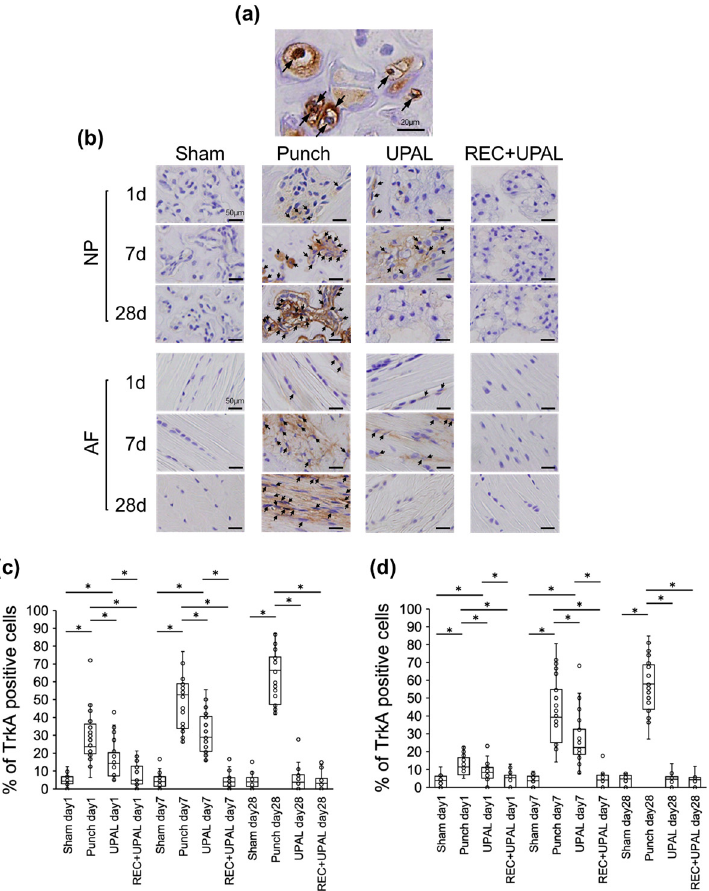
Figure 4. A mixed solution of REC and UPAL inhibits tyrosine kinase A (TrkA) receptor upregulation. Immunohistochemical analysis was performed on postoperative days 1, 7, and 28 to detect TrkA levels ( a – d ). ( a ) Representative image of TrkA-positive nucleus pulposus (NP) (allows). TrkA-positive cells are stained in brown, and nuclei are stained in purple. Scale bar, 20 μ m. ( b ) Representative IHC staining for TrkA of NP and annulus fibrosus (AF) tissues on postoperative days 1, 7, and 28. Arrows indicate TrkA-positive cells. Scale bar, 50 μ m. Percentage of TrkA-positive cells in NP tissue ( c ) and AF tissue ( d ). An asterisk (*) indicates a p -value less than 0.01. The boxes represent the median and interquartile range, while the vertical lines show the range at each time point (n = 3 rats; n = 6 IVDs in each group).